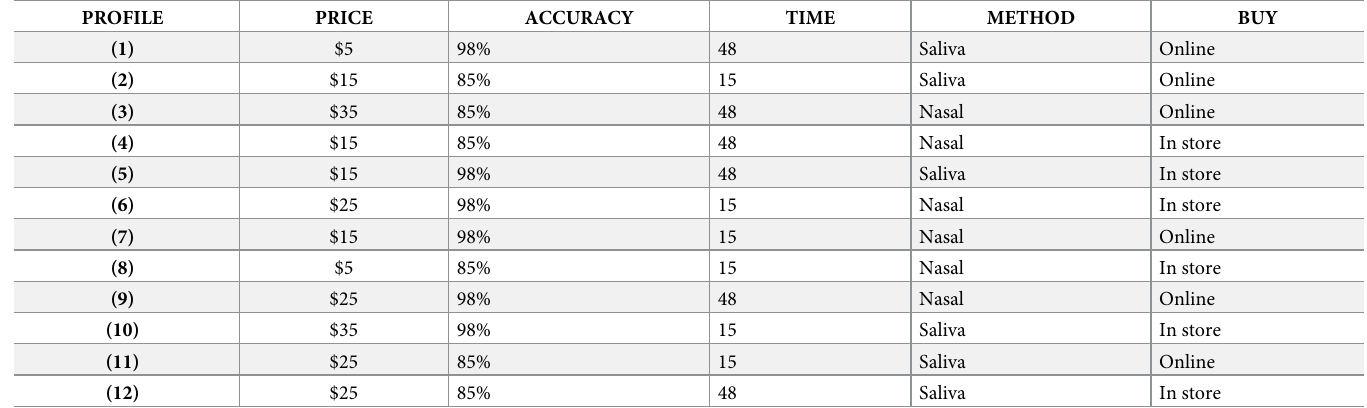
Table 2. Twelve conjoint